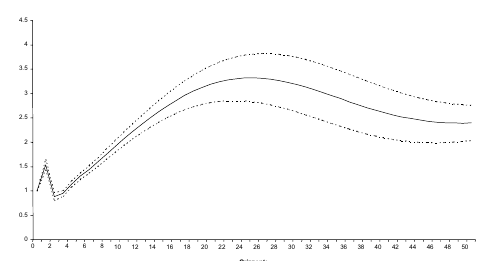
Figura 1a – Profilo di persistenza del settore Agricoltura (modello M3 ).